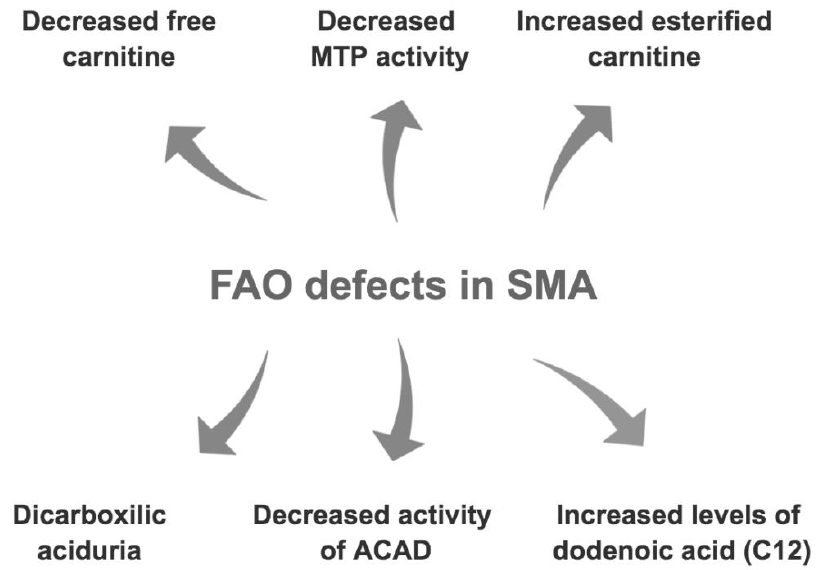
Figure 4. Summary of fatty acid oxidation (FAO) defects in SMA. Mitochondrial trifunctional protein (MTP), acyl carnitine dehydrogenase (ACAD).